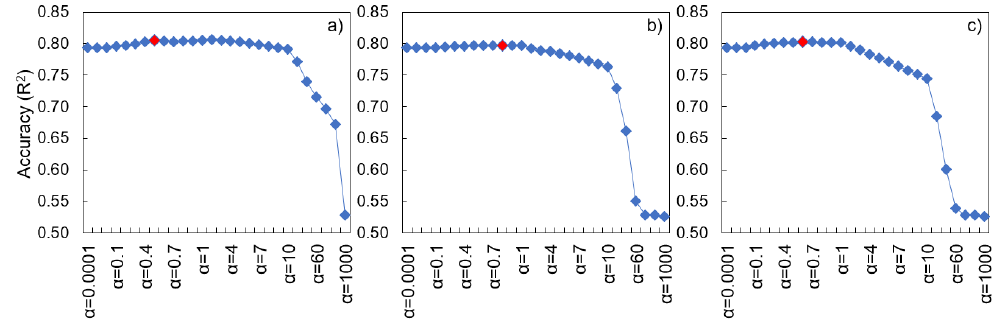
Figure 4. Decision tree model performance according to hyperparameter values (the minimum number of samples for each leaf [minimum samples leaf], split criteria, and maximum tree depth). The red diamond represents the hyperparameter value representing the optimal performance. 2.4. Model Validation and Evaluation To verify model performance, we applied leave-one-out cross-validation, a special case of k -fold cross-validation; this method can achieve more stable results than k -fold cross-validation for small datasets because it uses all samples for testing and training to ensure sufficient sample sizes [50 – 55]. To evaluate DWGR prediction model performance we used the MAE , RMSE , and R 2 : MAE = ∑